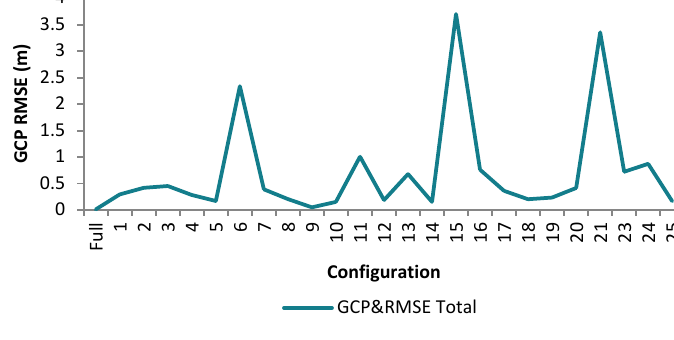
Figure 12. Total GCP RMSE plotted for each LOO config